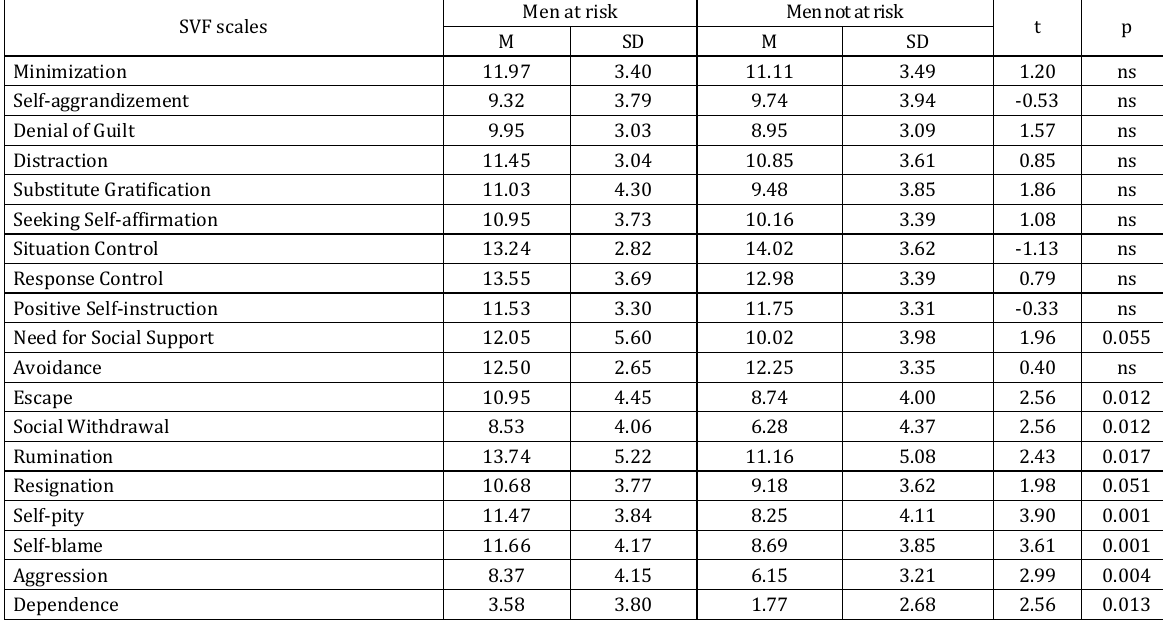
Table 3. A comparison of coping strategies in men at risk and not at risk of mobile phone addiction SVF